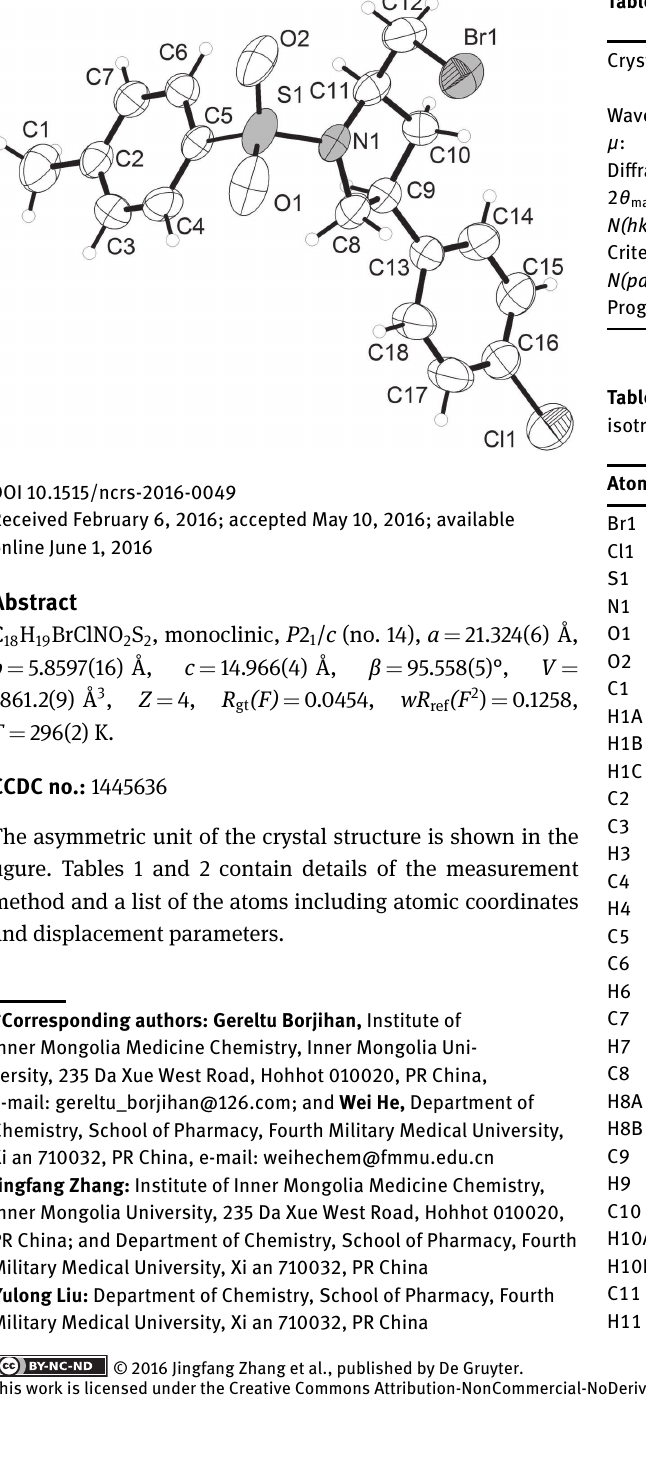
Table 1: Data collection and handling.